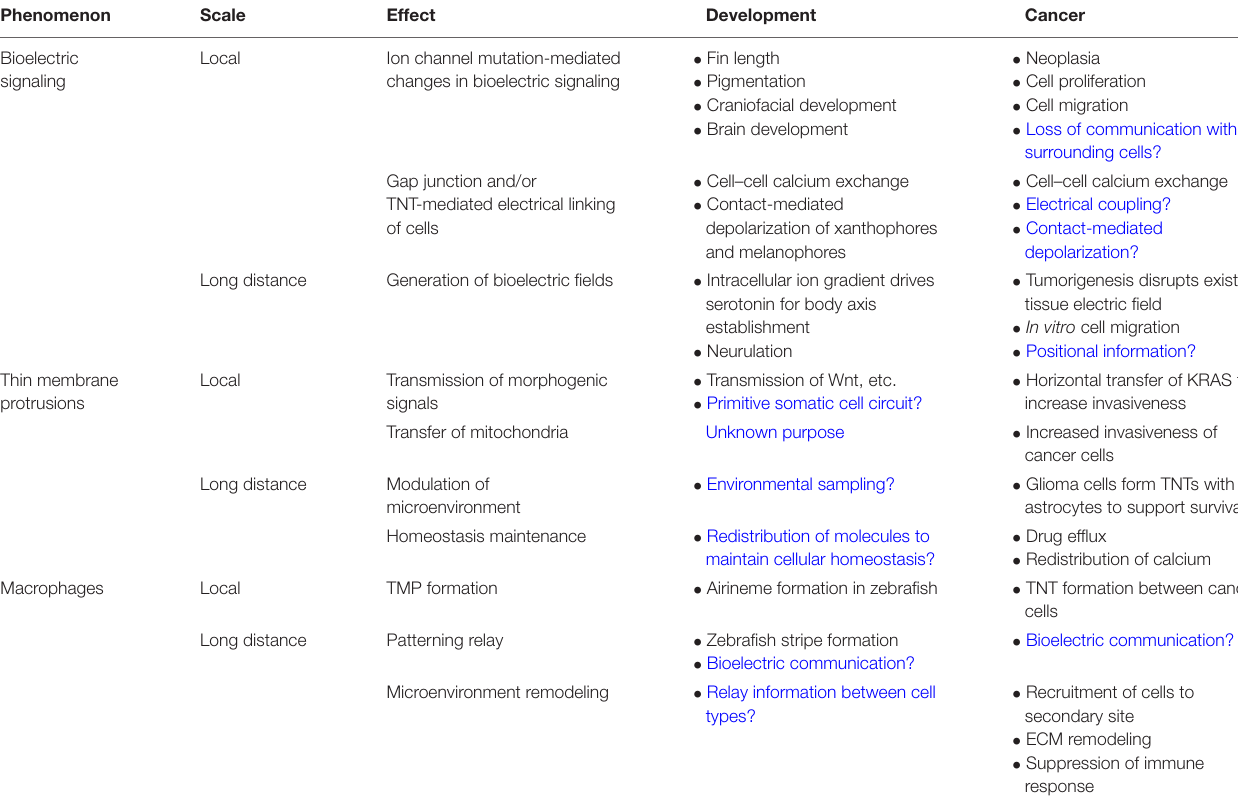
TABLE 1 | Comparison of phenomena involved in local and long-distance communication in development and cancer.